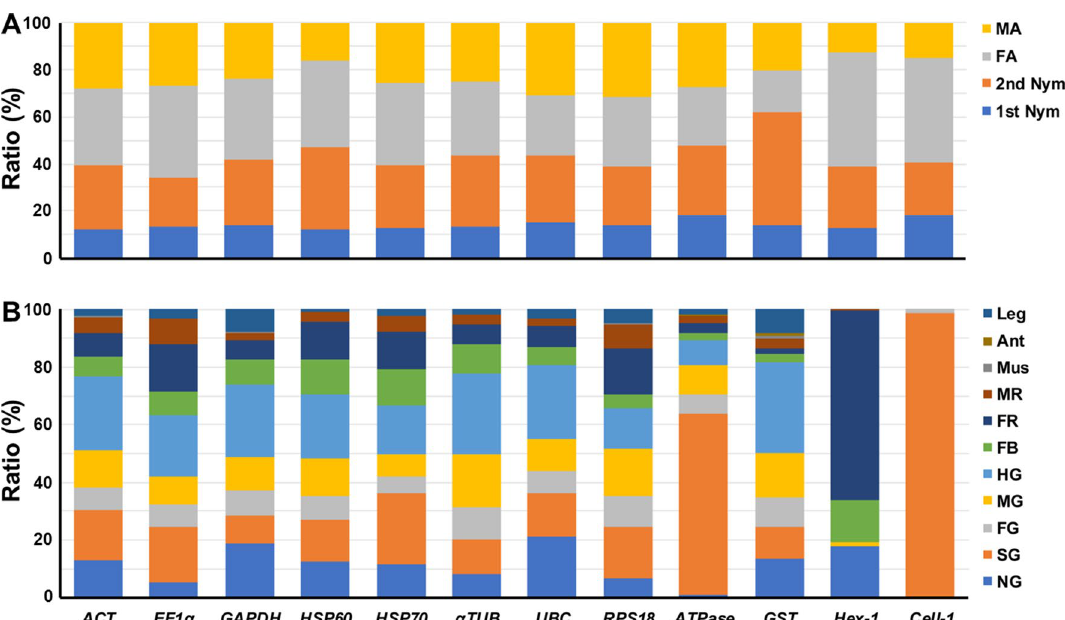
Figure 2. Relative expression ratios of candidate genes among different developmental stages and tissues. Relative expression ratio (%) is shown among ( A ) different developmental stages, including 1st Nym (1st nymph) and 2nd Nym (2nd nymph), MA (male adult), FA (female adult); and ( B ) different tissues, including NG (neuron ganglion), SG (salivary gland), FG (foregut), MG (midgut), HG (hindgut), FB (fatbody), FR (female reproductive organ, ovary), MR (male reproductive organ, testis), Mus (muscle), Leg, and Ant (antenna). The summation of a specific gene expression levels from samples of all the developmental stages or tissues are respectively regarded as